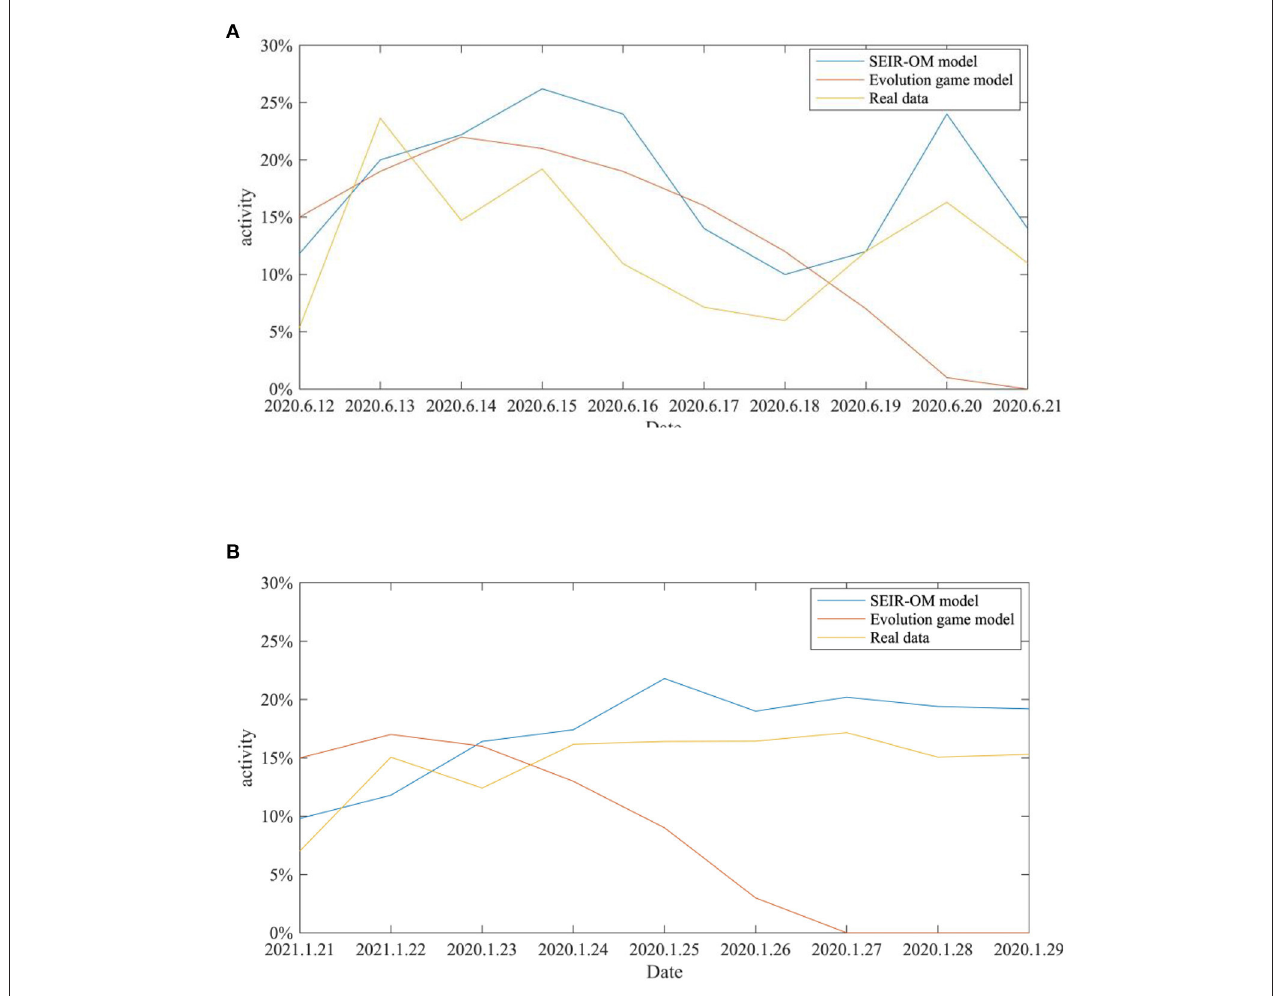
FIGURE 22 | Comparison of the network activities in the two incidents. (A) COVID-19 was detected on the surface of the imported salmon cutting board in Beijing. (B) COVID-19 was detected on the surface of the imported cherry in Wuxi.